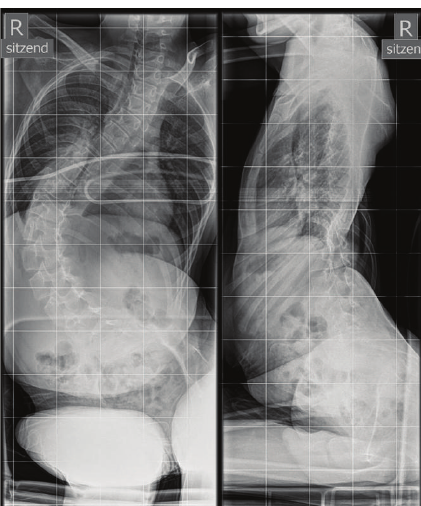
Figure 1: Male PD patient, 13 years old. Scoliosis right-convex C-shaped 90 ∘ Cobb Th6/L1/L5, before surgical spine stabilization. Pelvic obliquity 40 ∘ to the right. AP and sagittal radiograph.